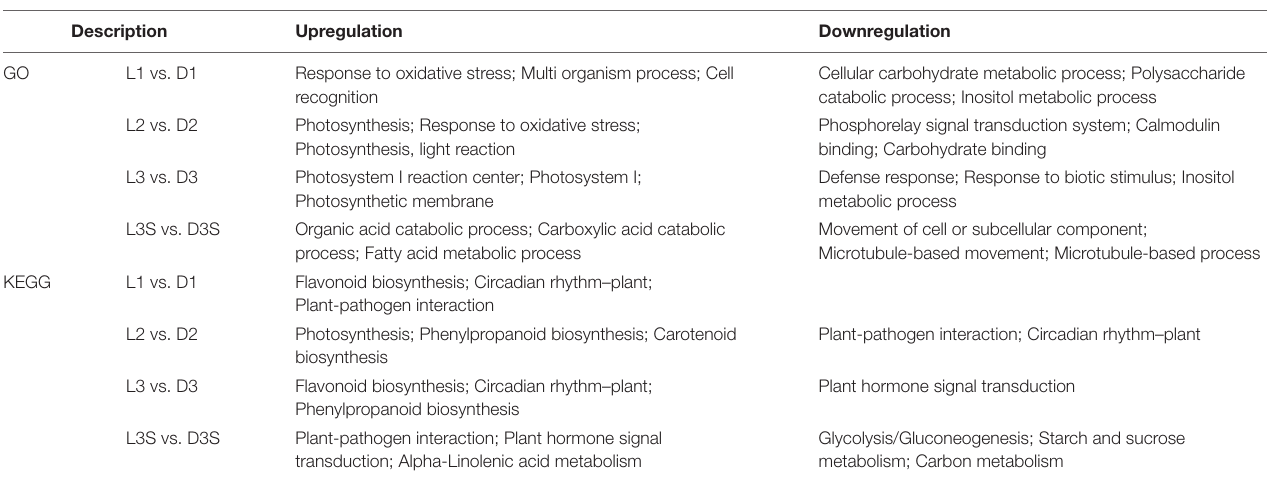
TABLE 3 | GO and KEGG enrichment analysis of DEGs in L vs. D